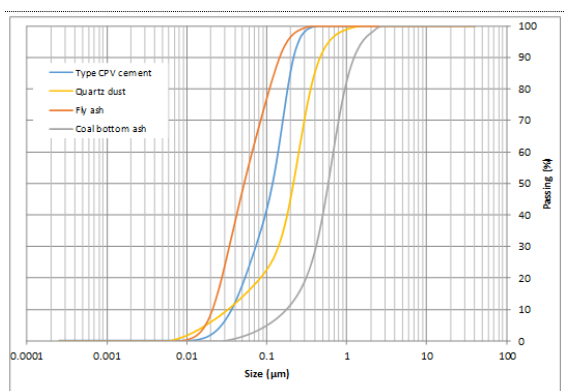
Figure 1. Particle-size distribution